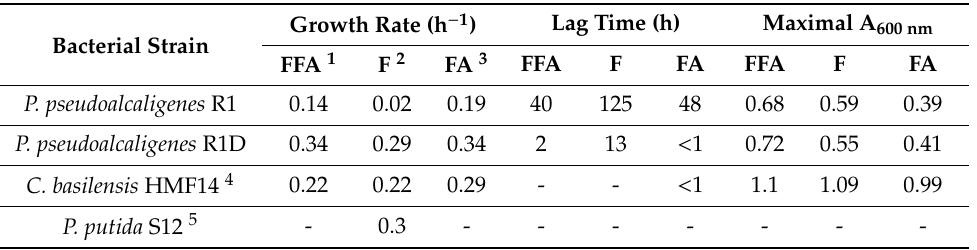
Table 2. Growth parameters of P. pseudoalcaligenes CECT 5344 R1 (wt) and the R1D mutant in comparison to bibliographic